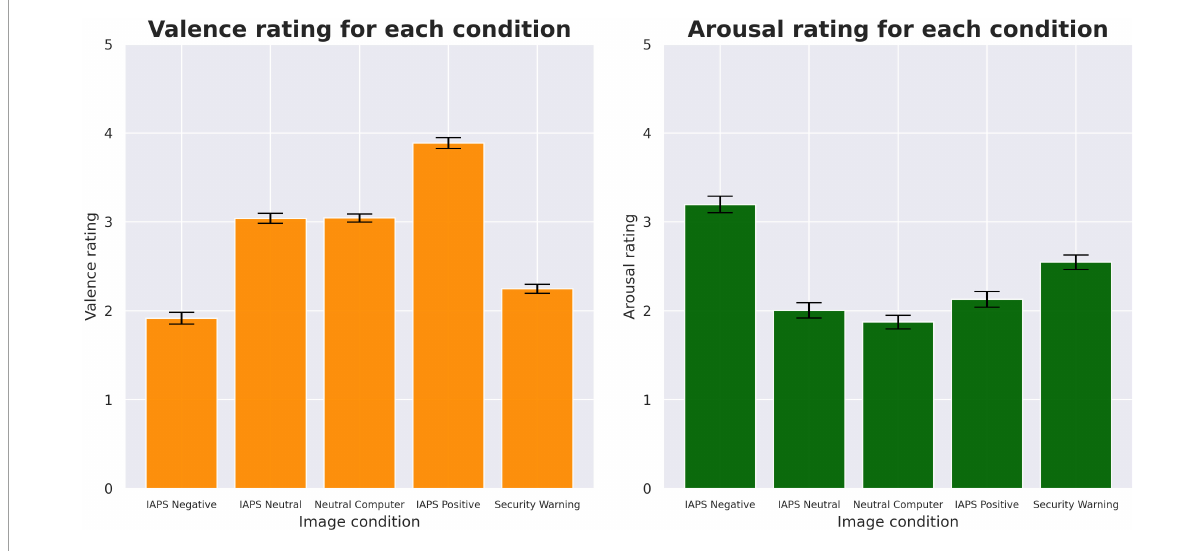
FIGURE4 Comparisons of SAM rating mean amplitudes with 95% confidence intervals. These means were assessed using ordinal regression with cumulative link models.